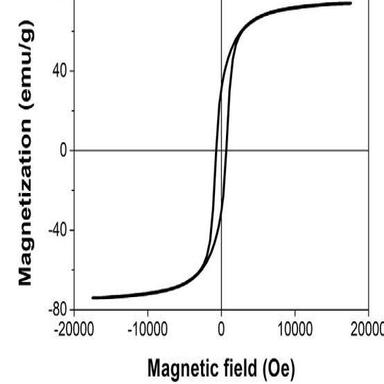
The magnetic hysteresis loop of PF-NiFe2O4.